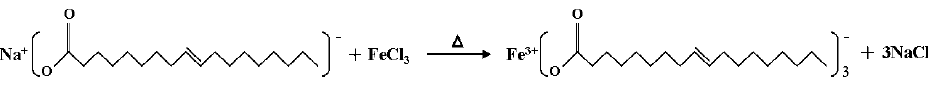
Figure 2. Preparation of Fe( III ) oleate.